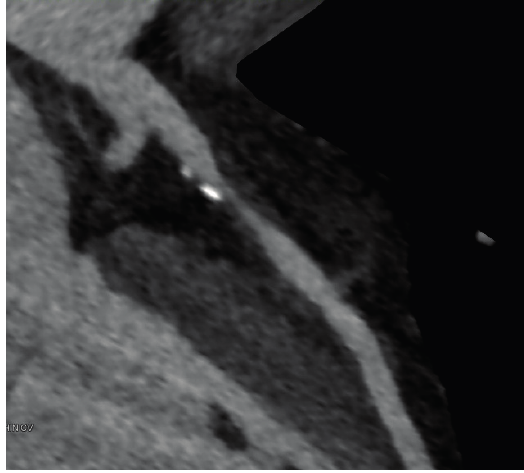
Figure 2. Predominantly noncalcified plaque with high-grade stenosis of